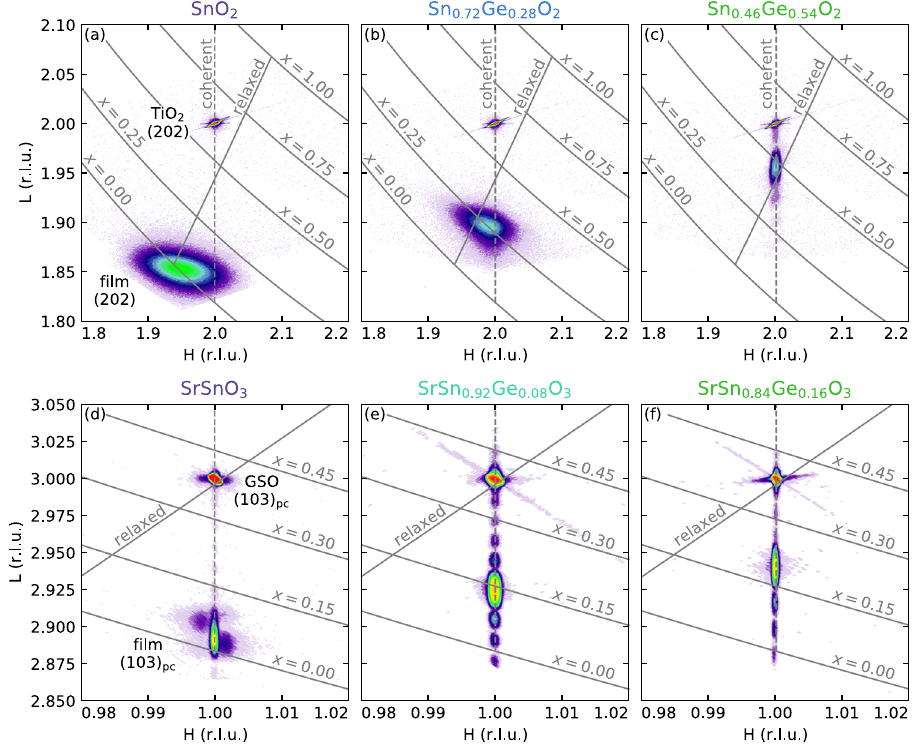
Fig. 4 Reciprocal space maps of Ge-based oxides. a – c Reciprocal space maps (RSMs) of rutile Ge x Sn 1- x O 2 /TiO 2 (001) fi lms in the (202) region. d – f RSMs of perovskite SrGe x Sn 1- x O 3 /GdScO 3 (110) fi lms in the (103) pc region. All RSMs include composition contours and relaxed/coherent guidelines to show the expected peak positions based on composition and